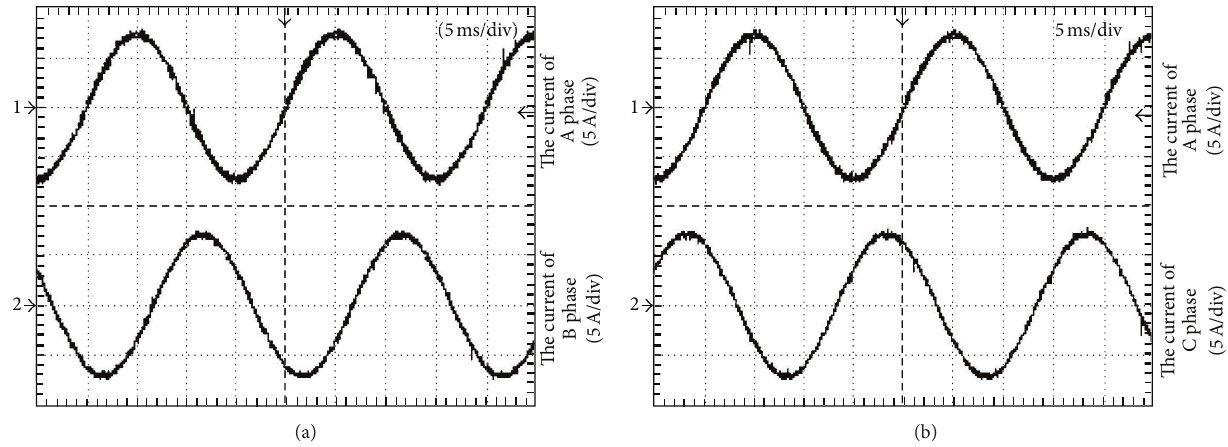
with three-phase discrete filter inductors, the volumes of the five-limb integrated filter inductors are reduced third, the three-limb integrated filter inductors are reduced two-thirds, and the filter effects of three kinds of filter inductors are almost the same; all can achieve the good filter effect.